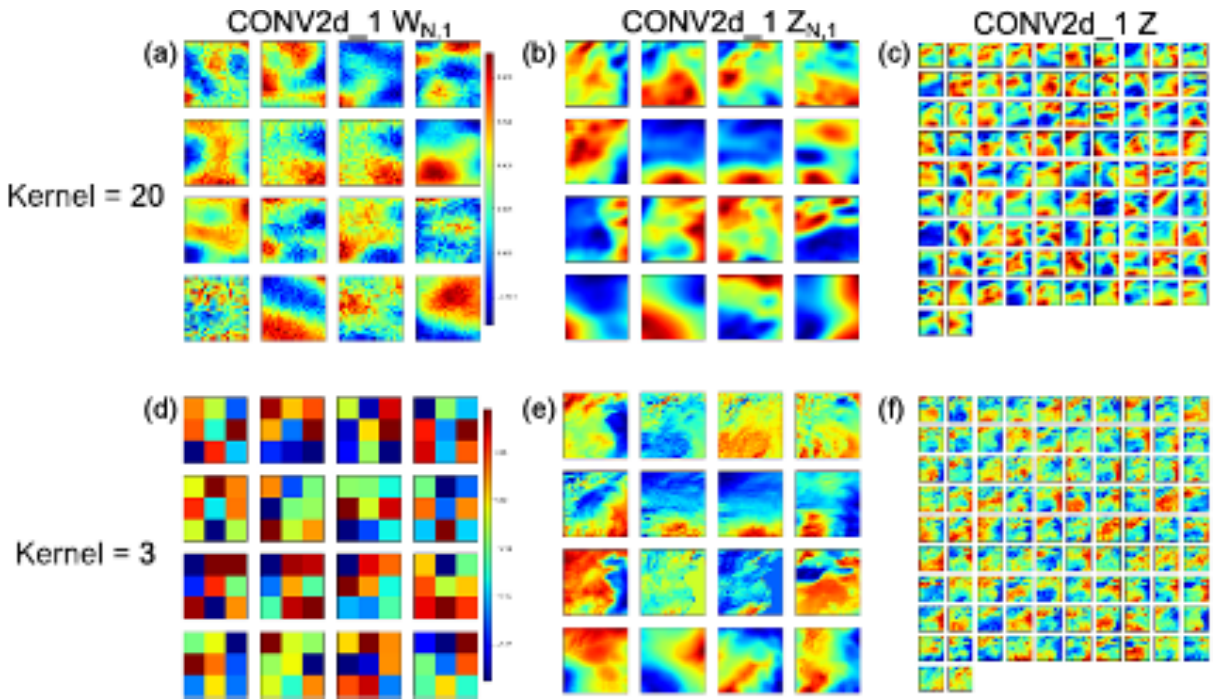
Figure 3. (a, d) Weight coefficients of the first filter set ( W N, 1 ), (b, e) partial output for each feature ( Z N, 1 ), and (c, f) the output ( Z ) of the first convolution layer (CONV2d_1) with two selected kernel sizes (ks): (a–c) 20 × 20 and (d–f) 3 × 3. Here W represents the filters and Z the output of convolution; the subsets of Z before the feature dimension is merged can be expressed as Z N,i = W N,i ( ks , ks ) · f T with the order of input features N = 1, ... 16 and i representing the convolutional layer index, i.e., 1 is the first layer or CONV2d_1. For the first layer, input feature size is (h,w) = ( 64 , 64 ) , the set of filters is 92, and thus the final output Z has a dimension of ( h − ks + 1, w − ks + 1, 92). Shown are the results from the training for Shanghai haze